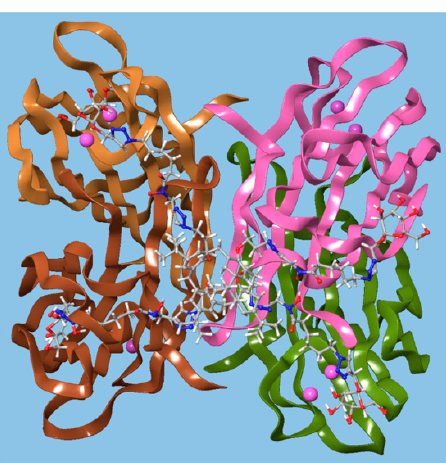
Figure 24. A glycosylated calixarene binding to a lectin. Reprinted with permission from [76]. Copyright © 2019 American Chemical Society.